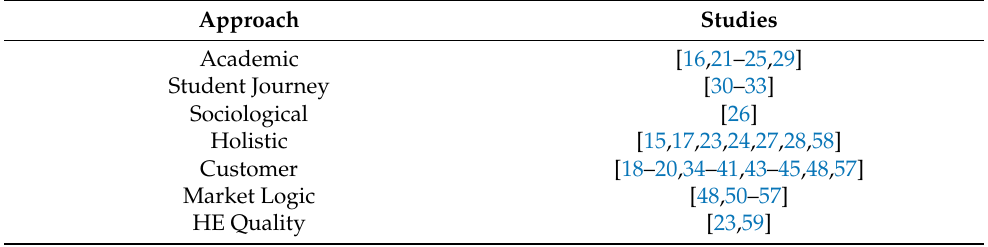
Table 4 indicates the different approaches to the SX concept and the associated studies. Table 4. Studies approaches to the SX